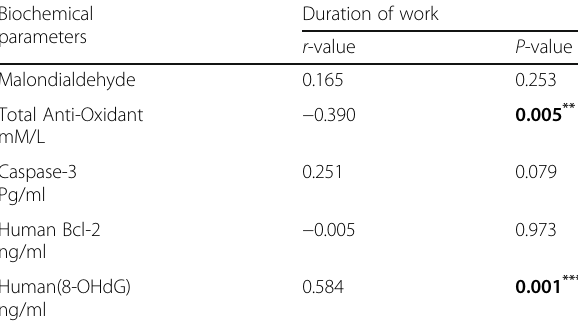
Table 9 Correlation between duration of exposure of workers (years) to paint hazards and different biochemical markers Biochemical